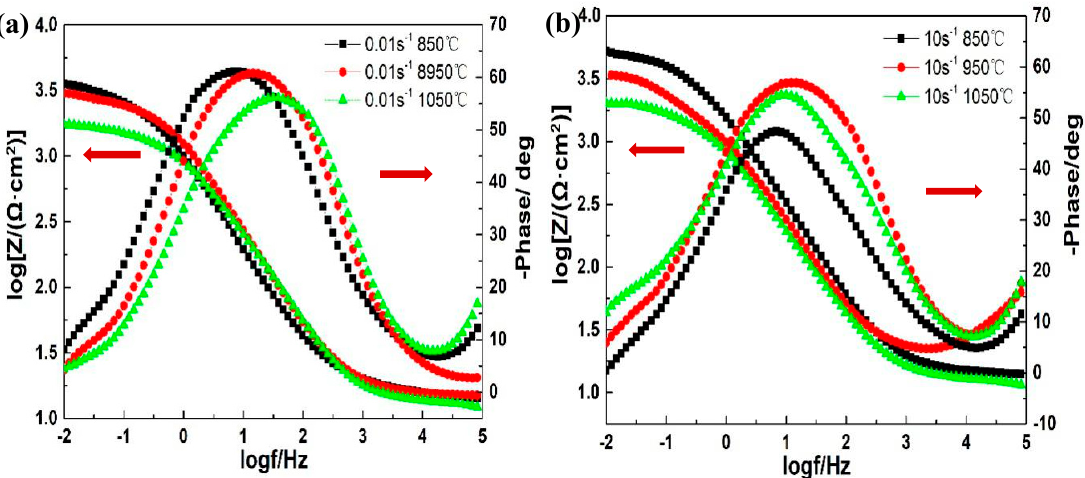
Figure 7. The Bode plots of 35CrMoV steel in 3.5 wt% NaCl solution: ( a ) 0.01 s − 1 , 850–1050 °C; ( b ) 10 s − 1 , 850–1050 °C.